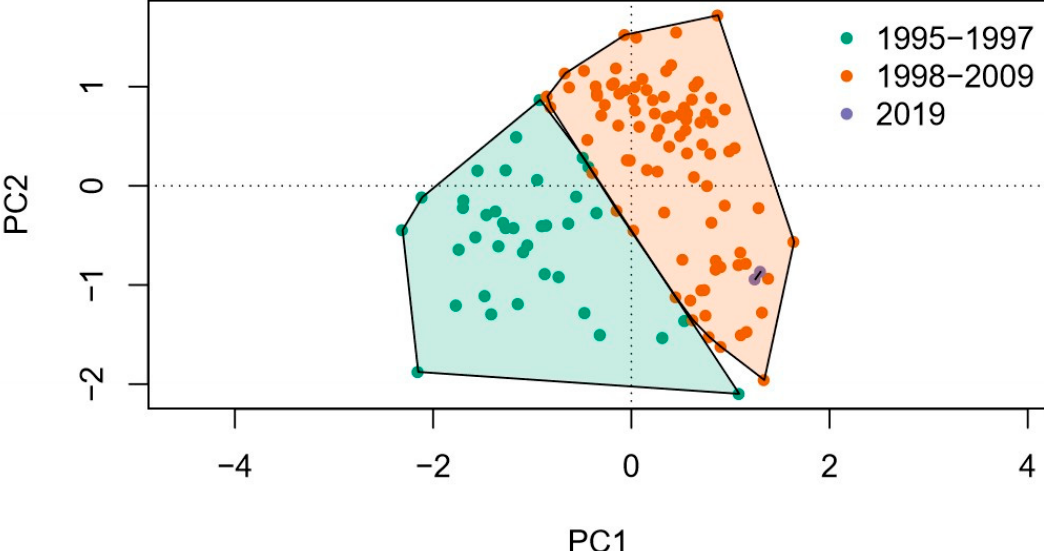
Figure 2. Plot of principal component analysis of deployed reed and natural reed samples from points c5 and c6 in the Cikola branch system. Different colors denote sampling periods.